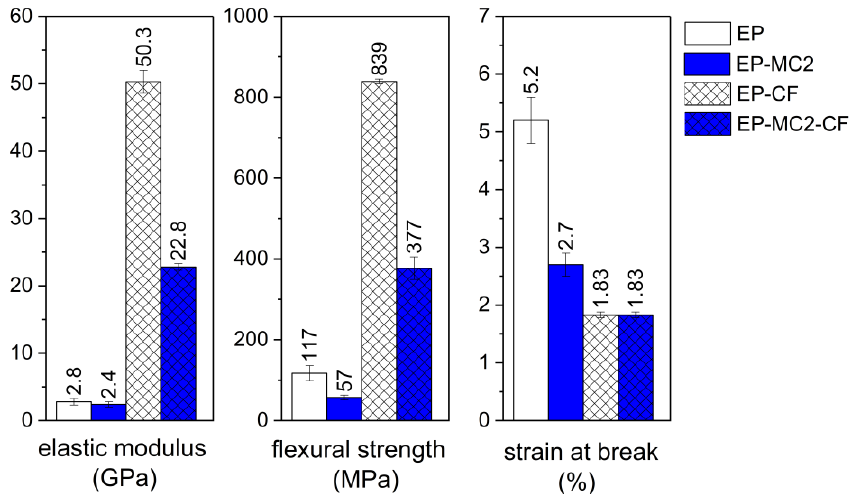
Figure 11. Main results of the three-point bending tests on the epoxy-based matrices EP and EP-MC2, and on the laminates EP-CF and EP-MC2-CF.